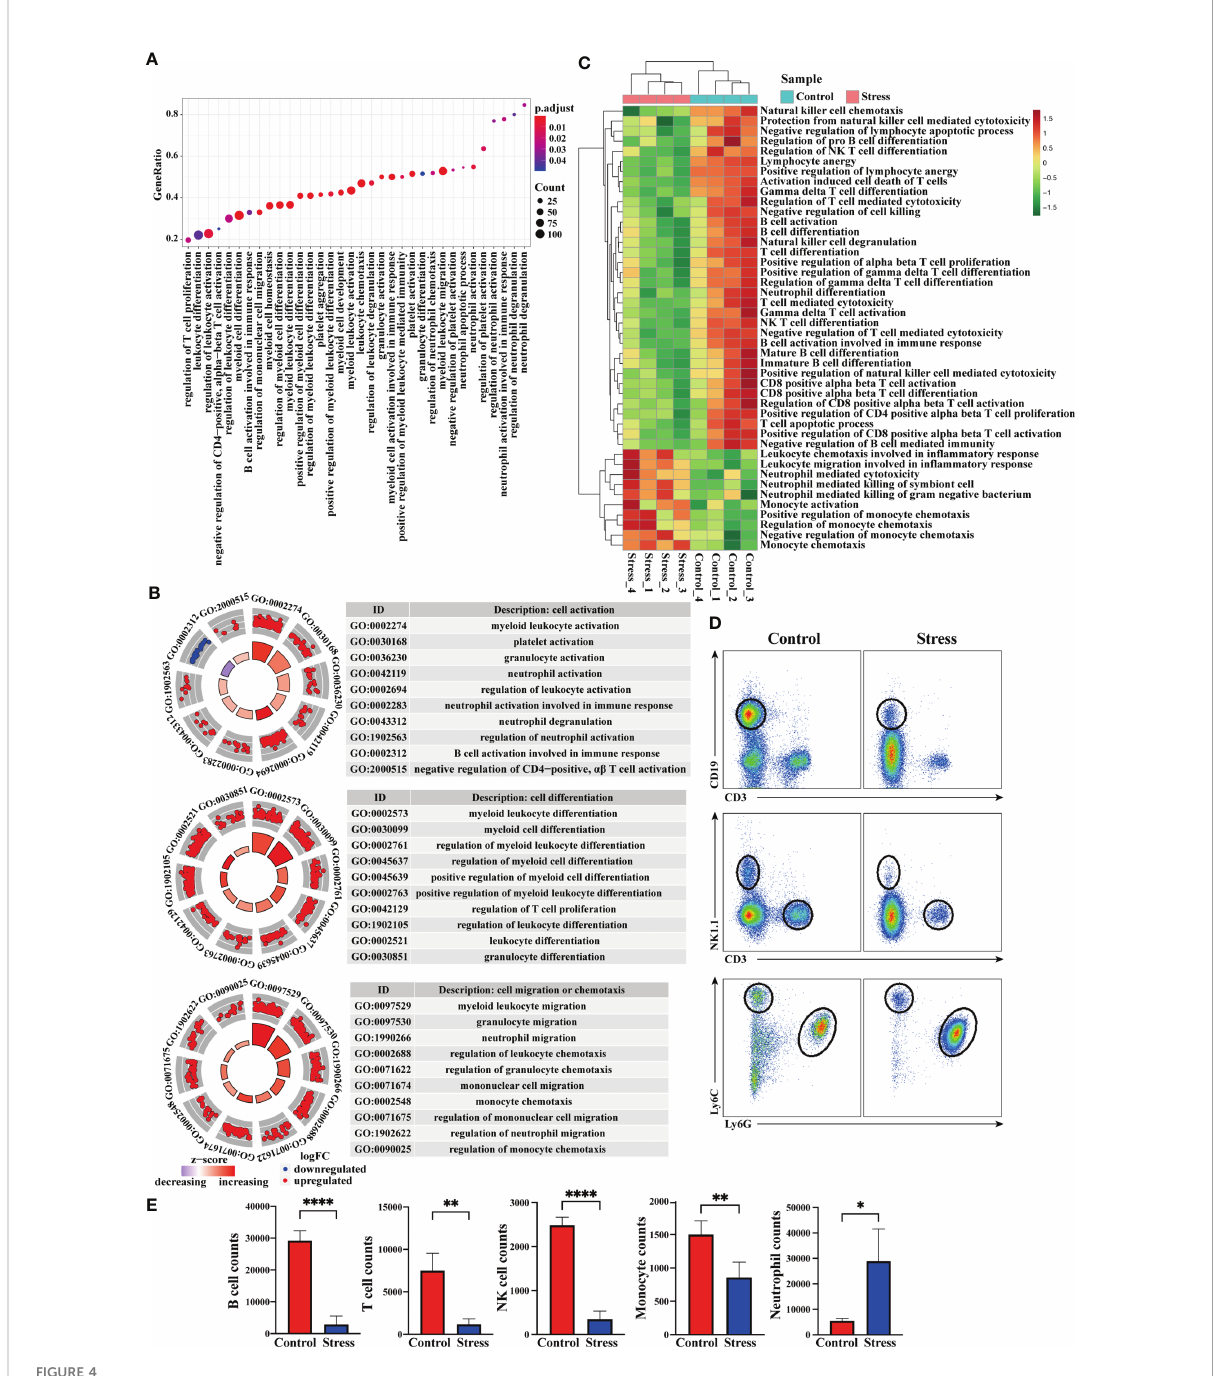
FIGURE 4 Analysis of gene expression at the cellular level and cell number in peripheral blood. (A) GO enrichment analysis of the whole transcriptome was performed through GSEA, and the biological processes represented by enriched gene terms were visualized at the cellular level. (B) Select some important gene terms related to cell activation, differentiation and migration, and then visualize the gene expression. (C) GSVA was performed on RNA-seq, and the differentially expressed gene terms were visualized at the cellular level. (D) At the same time, fl ow cytometry was used to analyze the changes of immunocytes in the peripheral blood between stress group and control group (n=4, per group). (E) Histograms represent the cell number counted by fl ow cytometry. Data are representative of 3 independent experiments. *P < 0.05, **P < 0.01, ****P < 0.0001. Means ± SD are